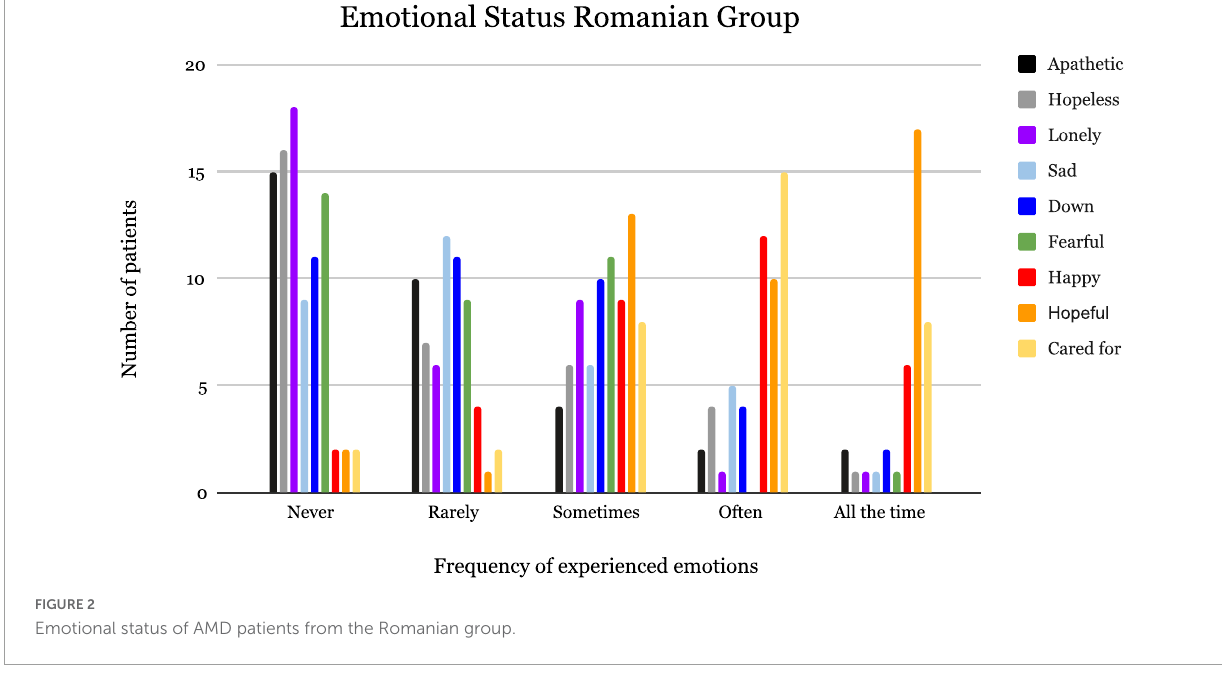
FIGURE2 Emotional status of AMD patients from the Romanian group.